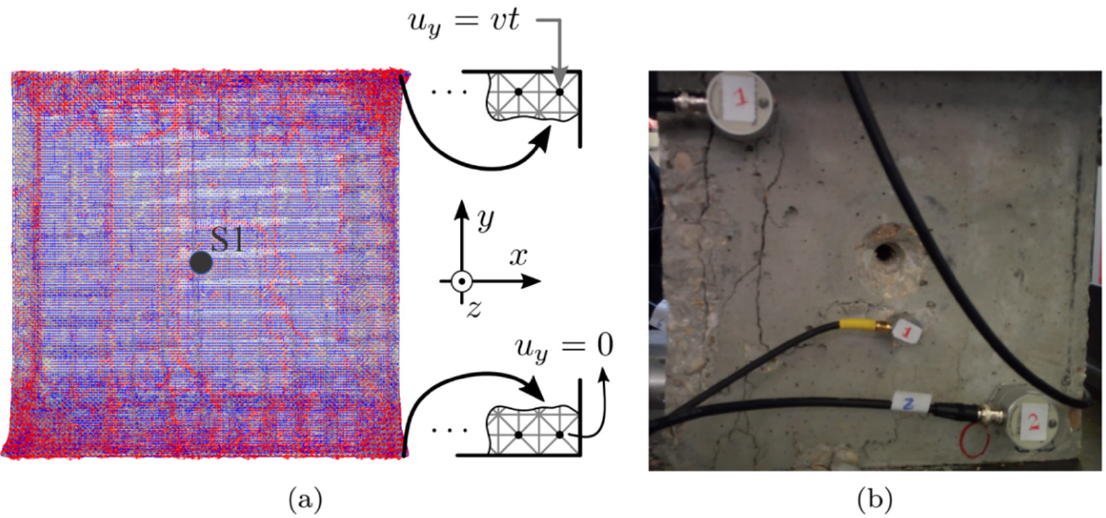
Figure 11. ( a ) Model discretization, boundary conditions, and simulated final rupture configuration. The red color represents fractured bars, and blue indicates partially damaged ones. Undamaged bars are omitted for enhanced visualization. ( b ) Experimental final rupture configuration.